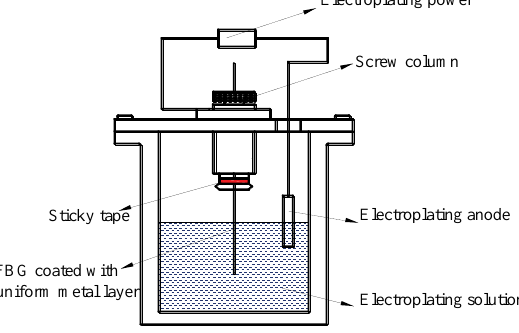
Figure 2. Schematic of the stepped-metal electroplating.